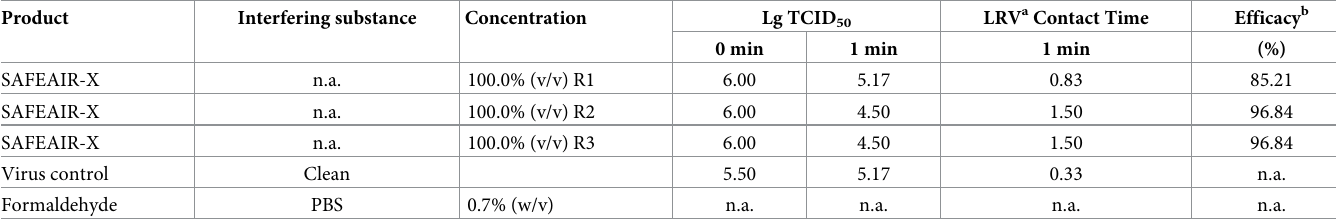
Table 5. EN 17272 surface test for the efficacy of SAFEAIR-X (CAN A 50/50) against Vaccinia virus ATCC VR-1549 (20˚C ± 1˚C) with virus